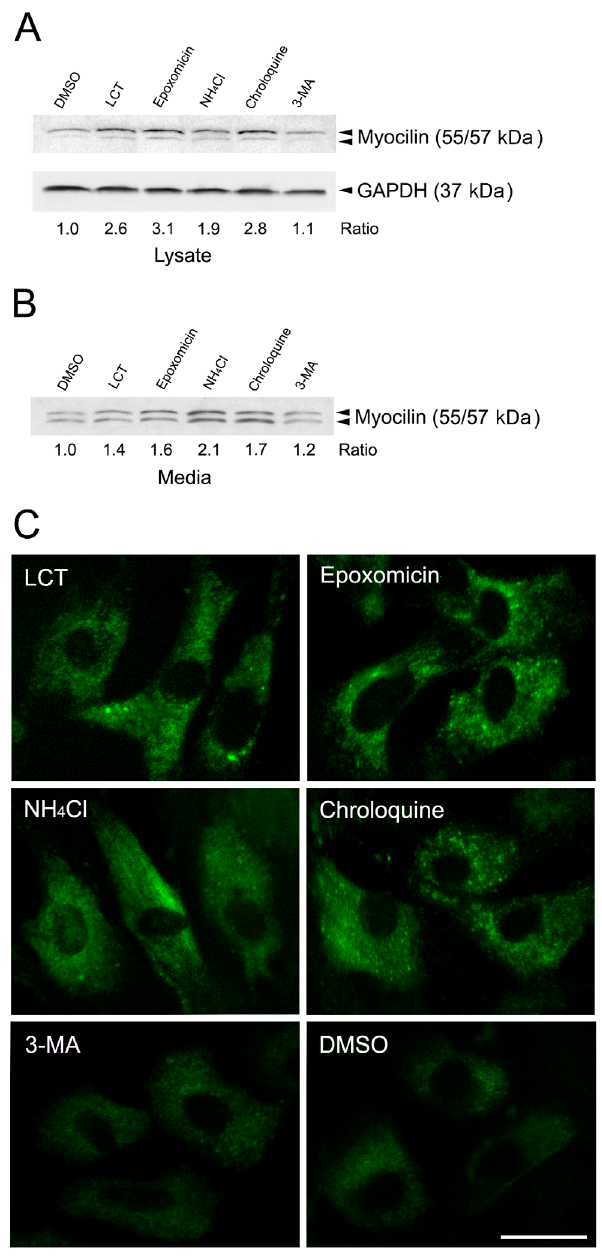
Figure 2. Effects of inhibitors on levels of endogenous myocilin. A . Western blotting. Human TM cells were treated for 16 h with vehicle DMSO or H 2 O (not shown), or proteasomal (LCT and epoxomicin), lysosomal (NH 4 Cl and chloroquin) or autophagic (3-MA) inhibitors. Proteins (25 m g) in cell lysates were immunoblotted with anti-myocilin or anti-GAPDH. Densitometry was performed. The myocilin/GAPDH relative to the DMSO control ratios are presented. B . Equal aliquots of media were immunoblotted with anti-myocilin. The level of myocilin in the media was normalized to that of the DMSO control. C . Immunofluorescence for myocilin. TM cells treated as above with the various inhibitors were fixed and immunostained for myocilin. All experiments were repeated at least 3 times, yielding similar results. Scale bar, 20 m m.